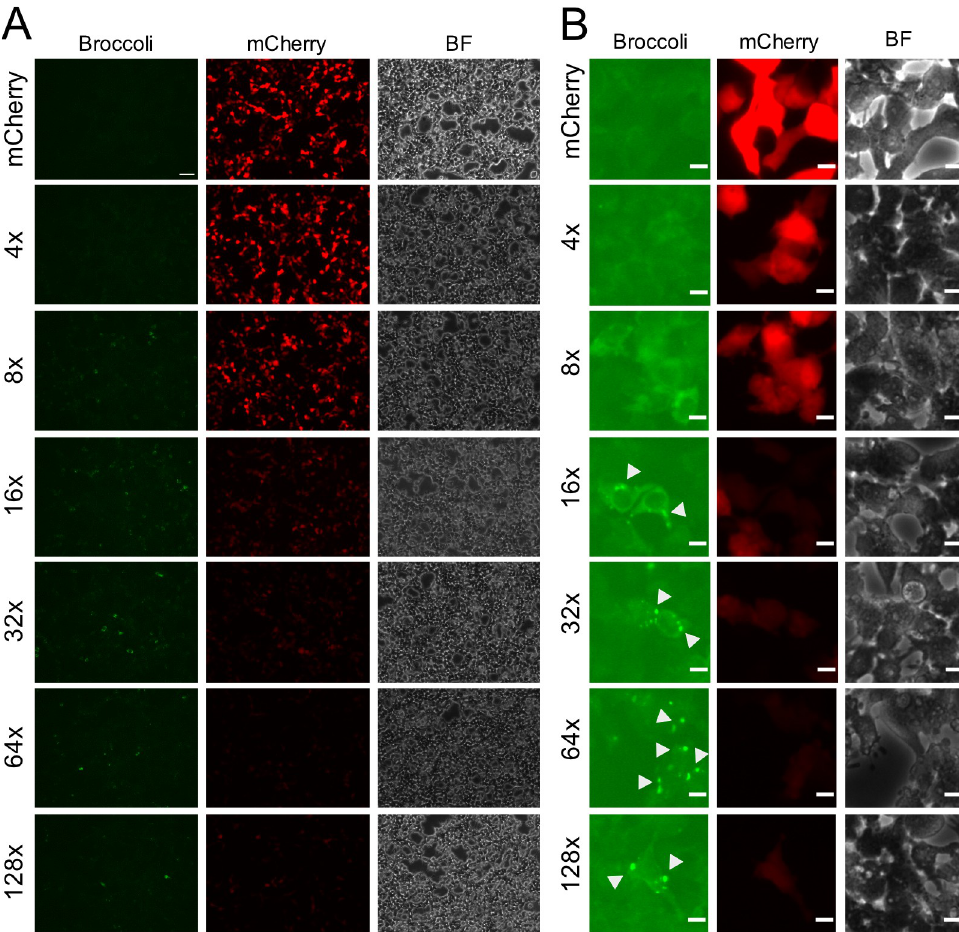
Fig 2. Broccoli exhibits punctate morphology. (A) 293T cells were transfected with mCherry, 4x, 8x, 16x, 32x, 64x, 128x Broccoli plasmids and analysed by microscopy for localization and morphology. (Scale bar = 75 μ m) (B) Representative higher magnification inserts illustrating subcellular Broccoli distribution (Scale bars = 10 μ